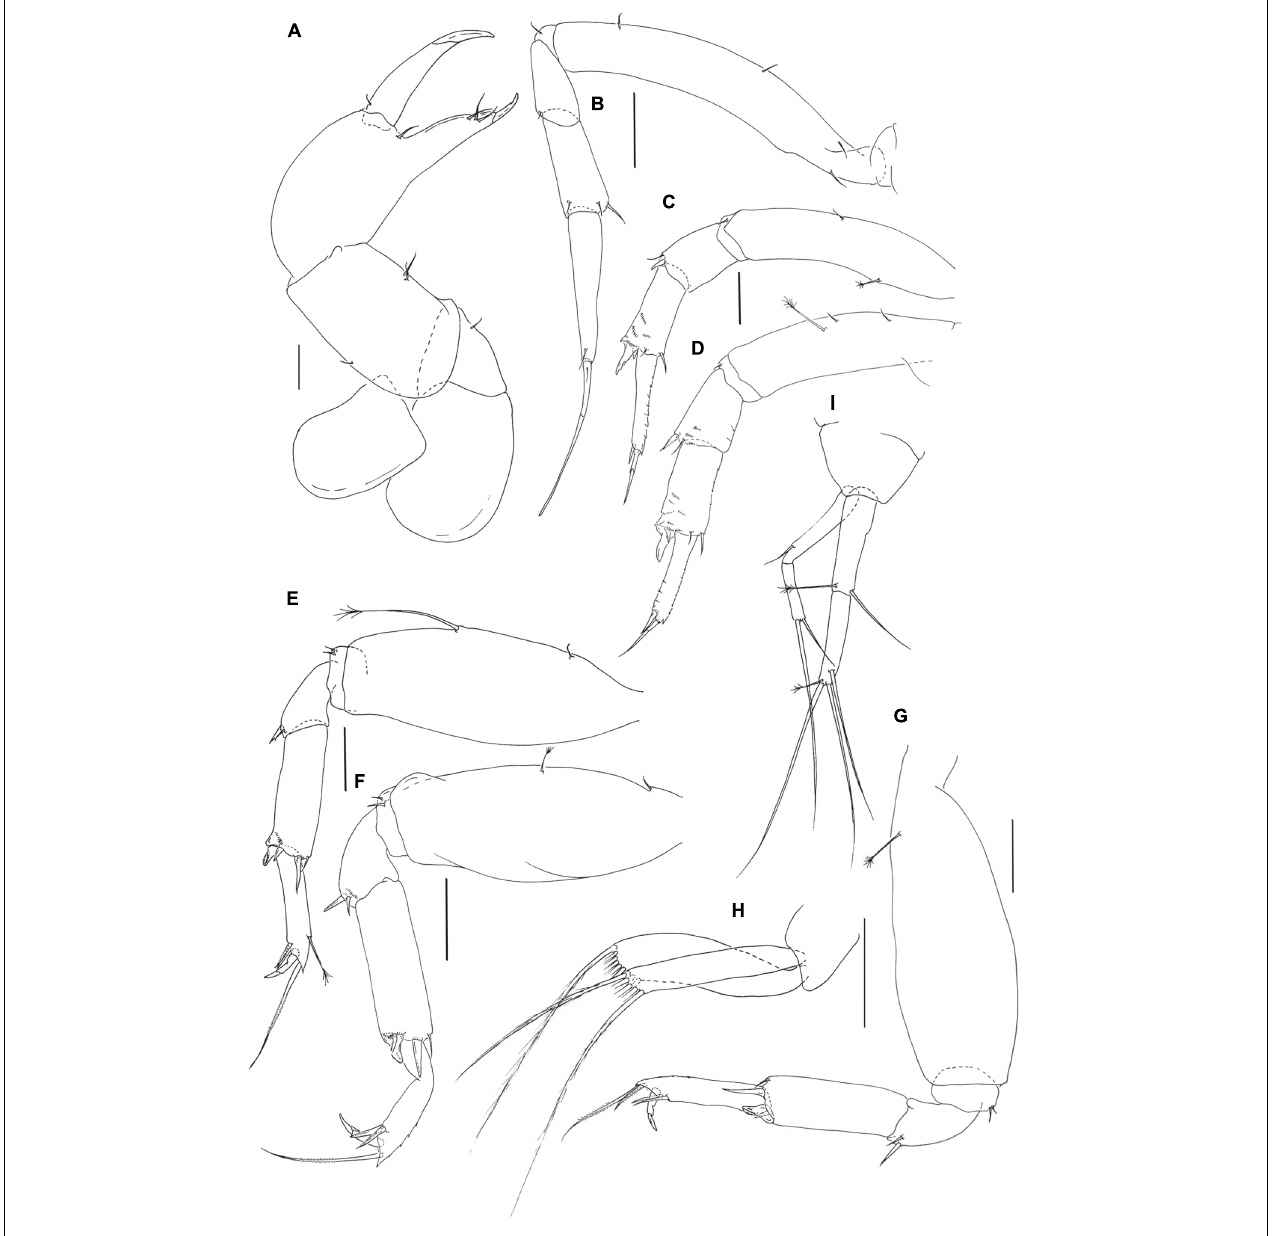
FIGURE 9 | Pseudotanais coonawarrai sp. nov.; neuter (J62734), (A) , cheliped; (B) , pereopod-1; (C) , pereopod-2, (D) , pereopod-3; (E) , pereopod-4; (F) , pereopod-5; (G) , pereopod-6; (H) , pleopod; (I) , uropod. Scale lines = 0.1 mm.